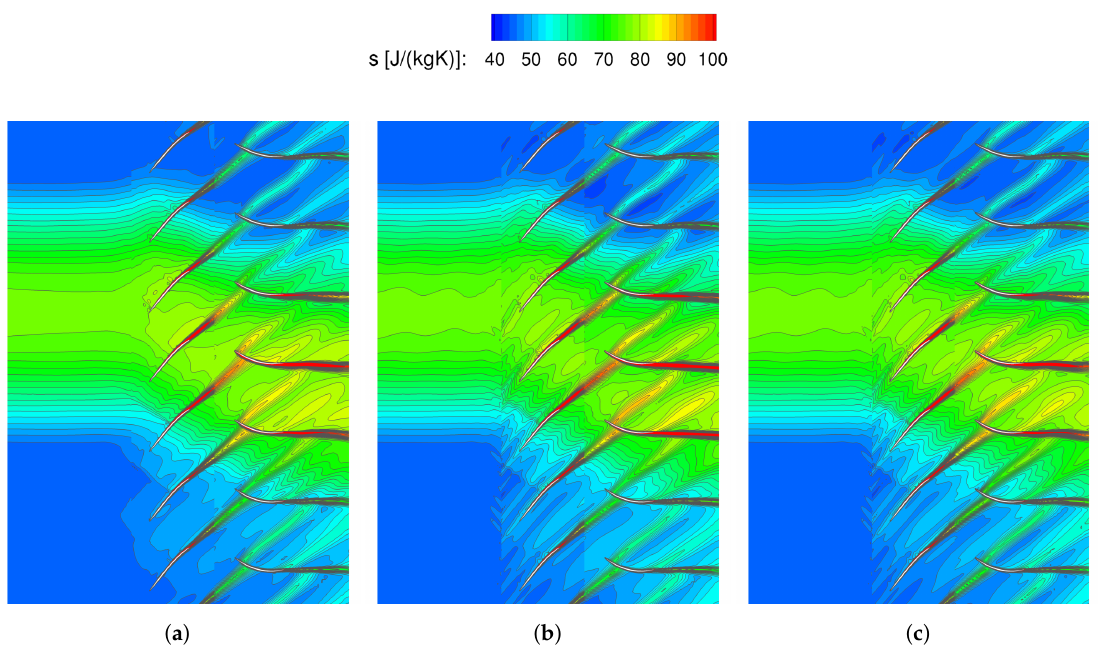
Figure 7. Entropy distribution at 90% relative radial height for time domain simulation ( a ); harmonic balance simulation with full annulus stator ( b ); and harmonic balance simulation with single stator and zero-frequency harmonic set ( c